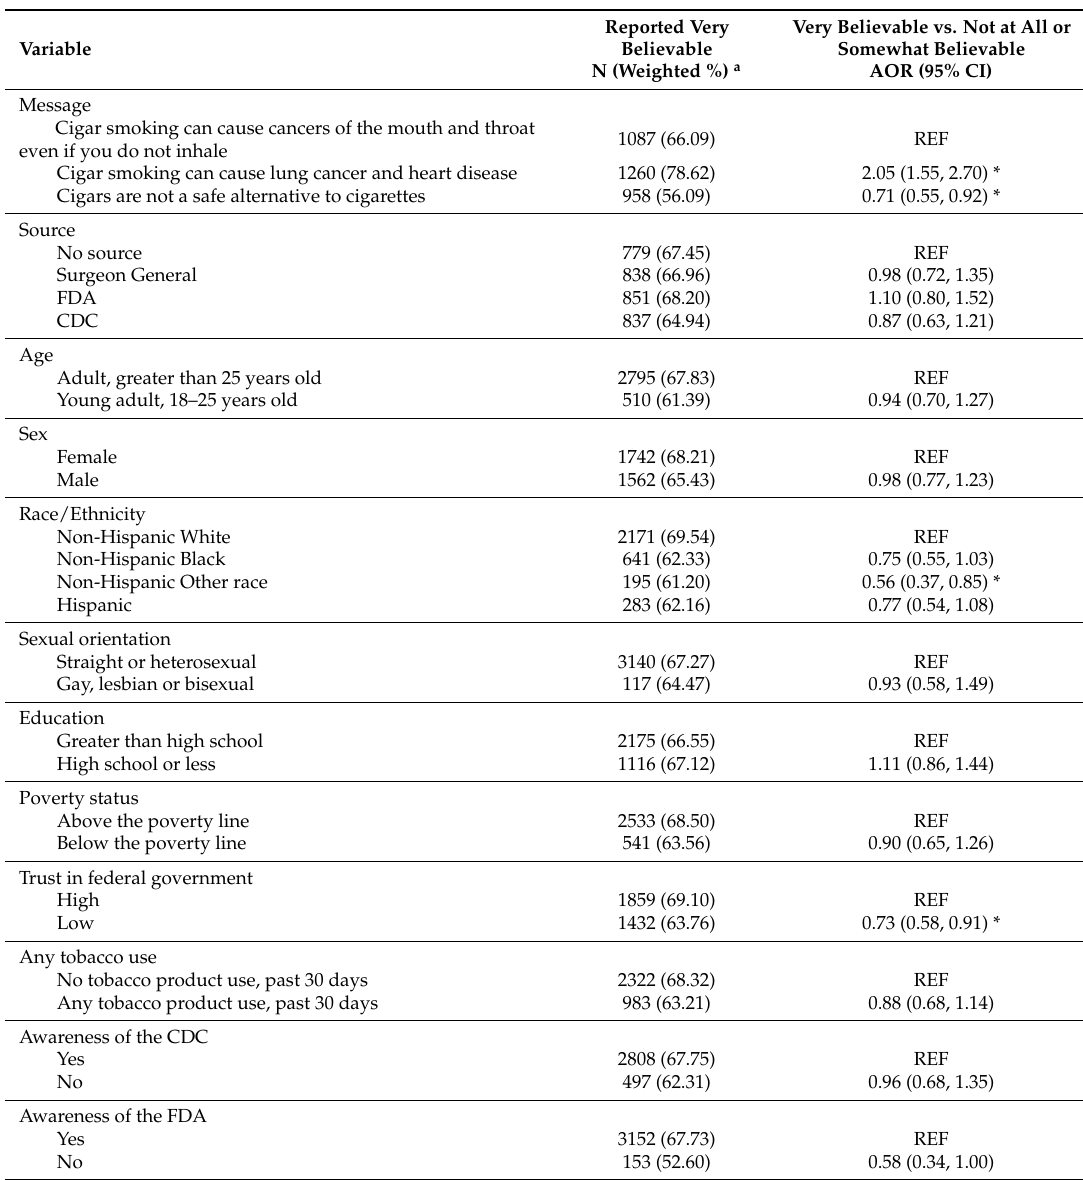
Table 3. Weighted logistic regression